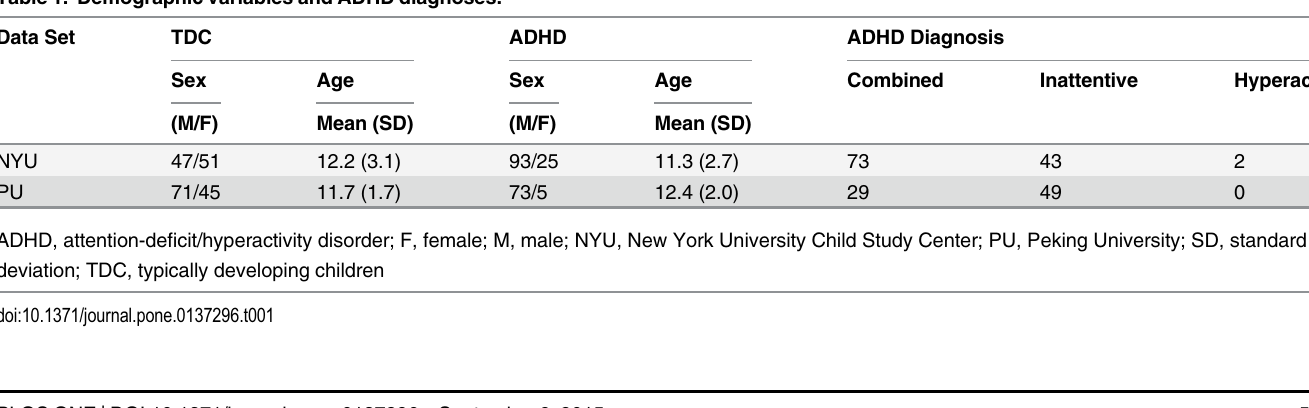
Table 1. Demographic variables and ADHD